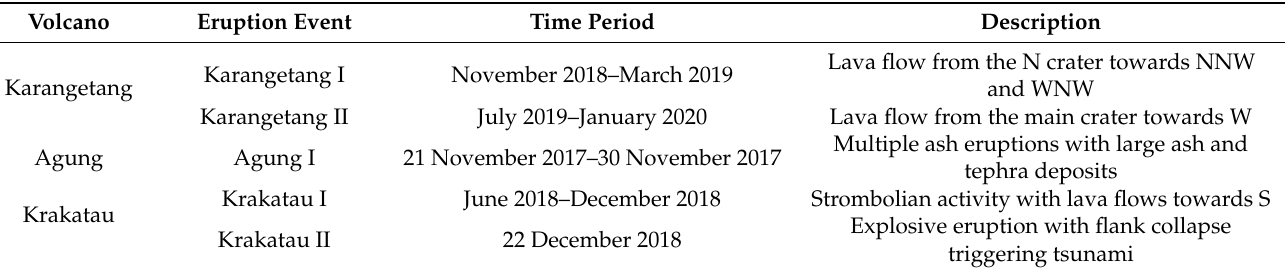
Figure 1. Study area in Indonesia with analyzed volcanoes Karangetang (2.781° N; 125.407° E), Agung (8.343° S; 115.508° E), and Krakatau (6.102° S; 105.423° E). For Karangetang and Krakatau, the derived lava areas are displayed. Zoom-in maps of volcanoes based on Sentinel-2 imagery (Karangetang: 20 November 2019; Agung: 18 September 2017; Krakatau: 17 September 2018). Basemap made with Natural Earth (www.naturalearthdata.com). Table 1. Analyzed volcanoes and eruption